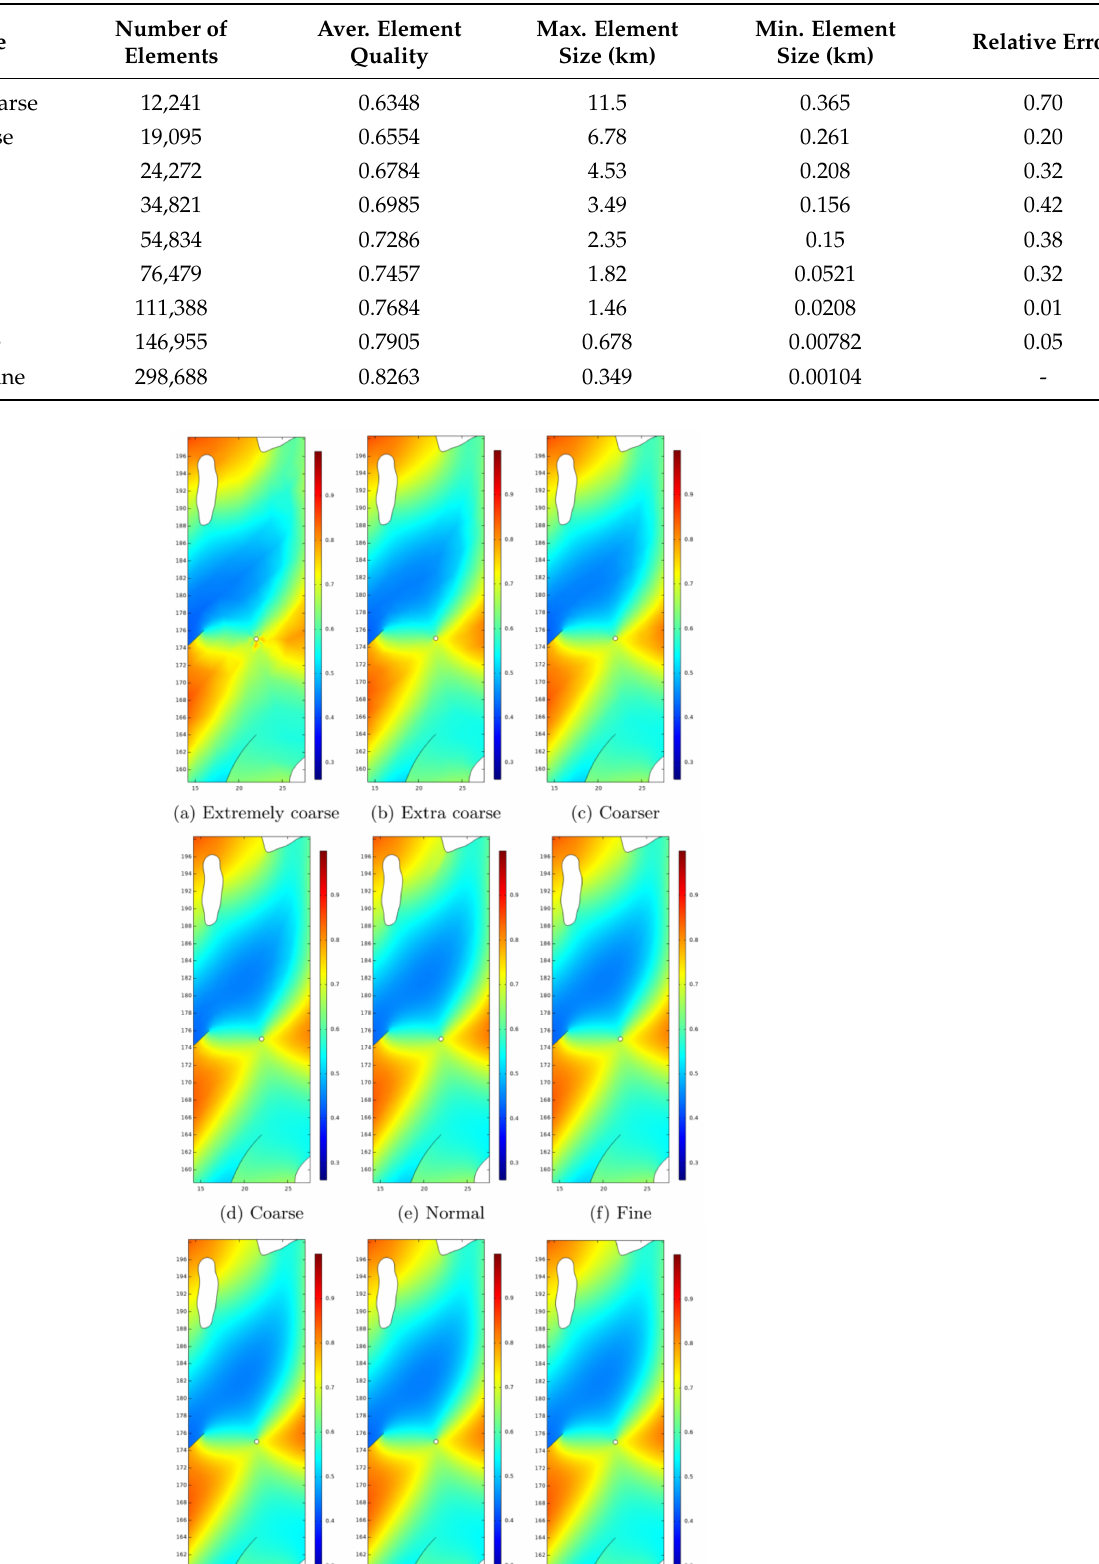
Table 2. Element characteristics of different mesh sizes.